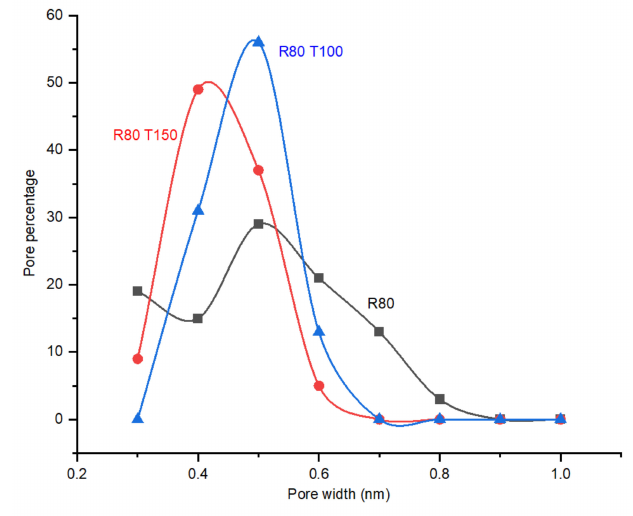
Figure 8. The effect of post treatment time (100 and 150 min) with 10% (molar) oxygen at 120 ◦ C and 6 bar on the PSD (Pore Size Distribution) of the CMSM (Carbon Molecular Sieve Membrane) R80.